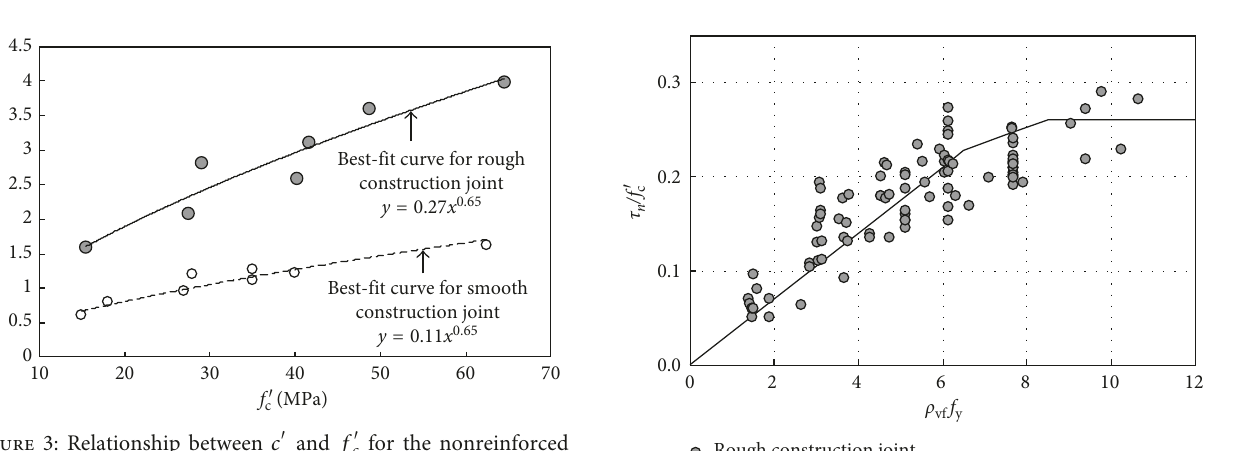
and f c for the nonreinforced ′ ′